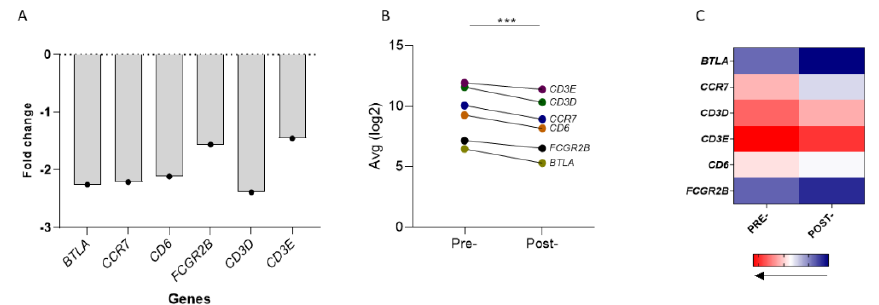
Figure 2. Alterations in gene expression of the 6-GS in the peripheral blood of 23 LPCa patients before and after RT. ( A ) Scatter dot plot representing fold change (FC) in the six genes pre-RT and post-RT. FC values were generated by conversion of the normalized average log2 values corresponding to gene expression levels pre-RT and post-RT. Data are presented as means. ( B ) The 6-GS is significantly downregulated post-RT (*** p < 0.0001). The depicted lines represent the conversion of each described gene from higher (pre-RT) to lower levels (post-RT). ( C ) Heat map showing the range of differential expression levels of the six genes. For the analysis, the median expression levels of each gene, pre-RT and post-RT, were used. The expression level values were normalized by RPM, log2-transformed and then median-centered for each patient. Different colors indicate different levels of gene expression: from red (high expression, max. value 12.43) to blue (low expression, min. value 6.42).